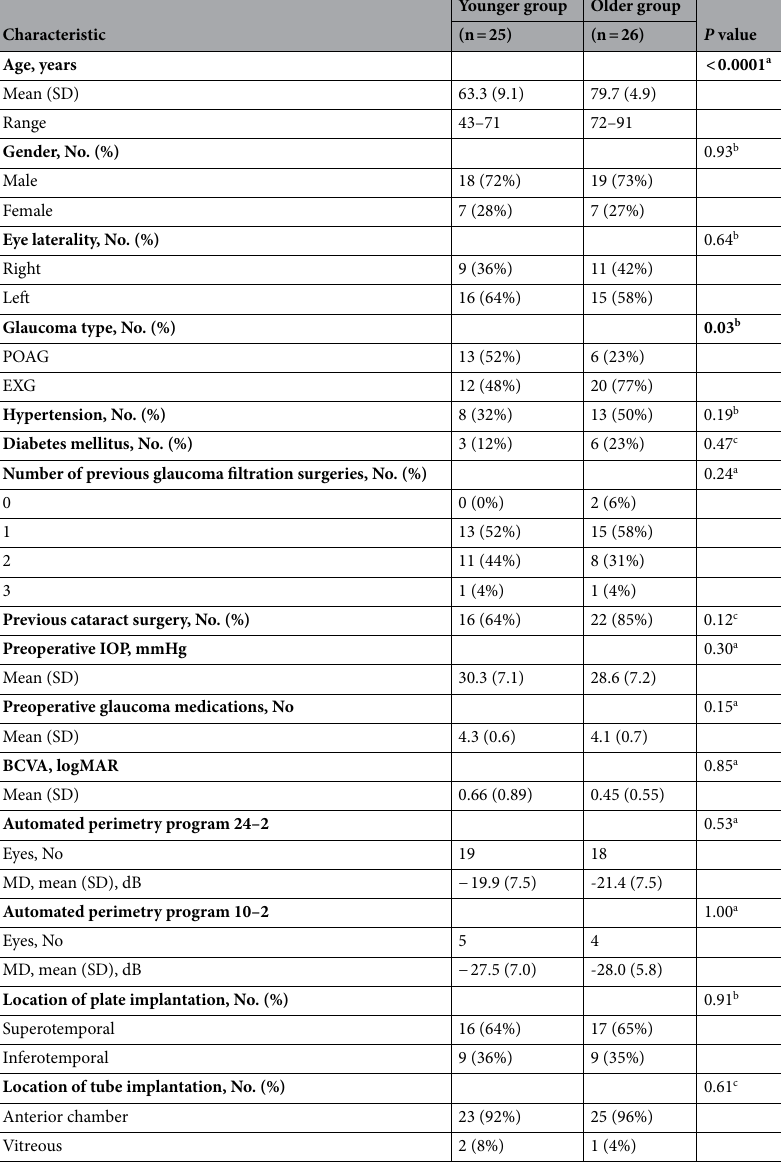
Table 3. Comparison of the baseline characteristics between patients with OAG in the younger and older groups. OAG open-angle glaucoma, SD standard deviation, POAG primary open-angle glaucoma, EXG test. P values < 0.05 are shown in